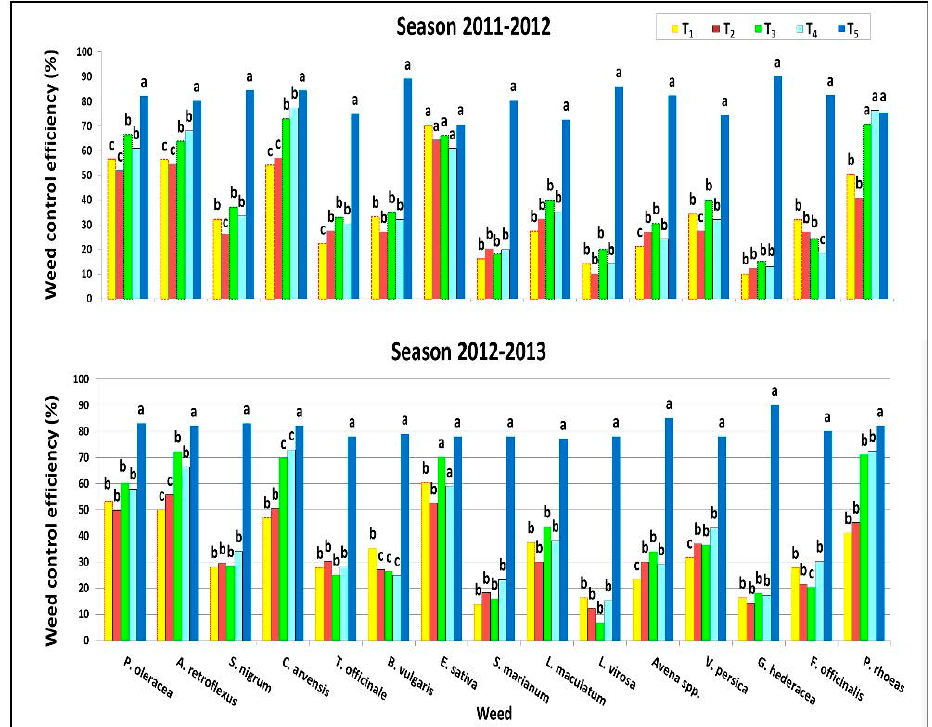
Figure 1. Mean weed control efficiency of different treatments on different weeds. Values within each weed species that have the same letters are not significantly different ( p ≤ 0.5, Tukey’s test).